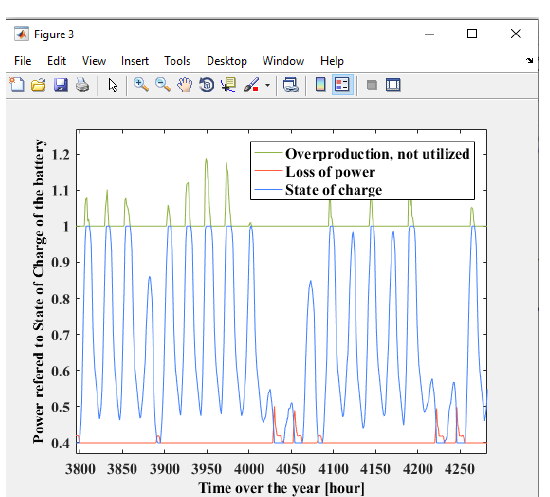
Figure 5. Energy Produced and estimated load profile over day (Comparison of Time with Energy)